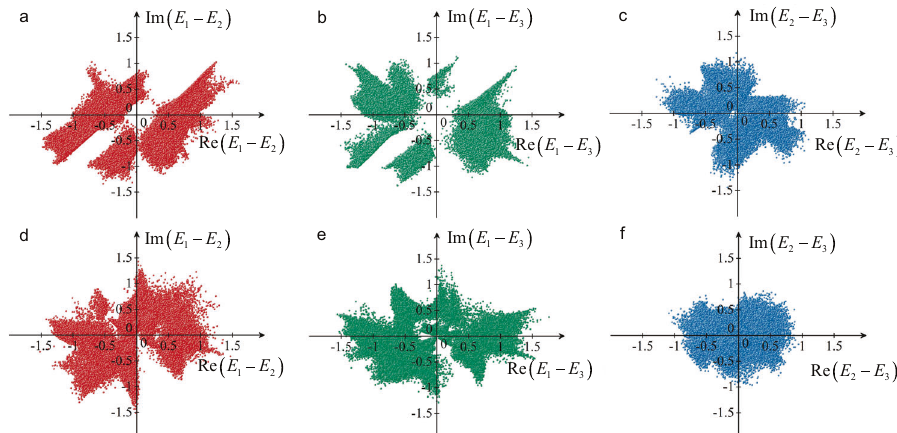
Fig. 2 Difference between eigenvalues ( E 1 , E 2 , E 3 ) of gradient index metasurfaces and non-local metagratings. The x -axis represents the real part of the difference while the y -axis shows the imaginary part. The dots represent samples with randomly assigned imaginary parts of sound speed for gradient index metasurfaces ( a – c ) and samples with randomly assigned real and imaginary parts of sound speed for non-local metagratings ( d –